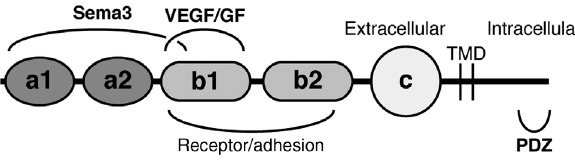
Figure 1 Nrp structure. Nrps contain a large, modular extracellular region that facilitates binding to multiple ligand families in both a competitive and non-competitive fashion. Ligand binding is coupled to intracellular signaling through PDZ-domain-containing adaptor proteins that bind the SEA motif of the Nrp cytoplasmic